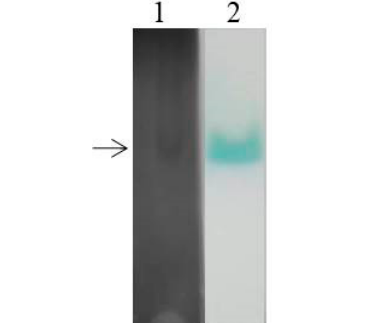
Figure 4. BN-PAGE analysis of laccase isozyme. The crude laccase was used for BN-PAGE. Lane 1: Coomassie Brilliant Blue staining, Lane 2: ABTS staining.